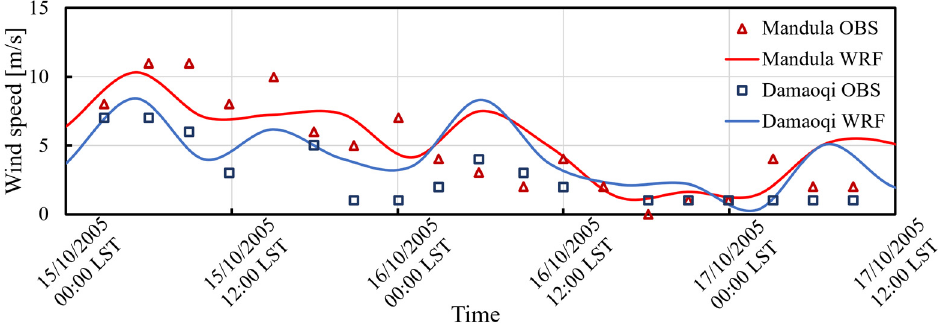
Figure 7. Variation of near-surface wind speed above the main landing area from WRF and weather stations from 00:00 LST on 15 October 2005 to 12:00 LST on 17 October 2005.